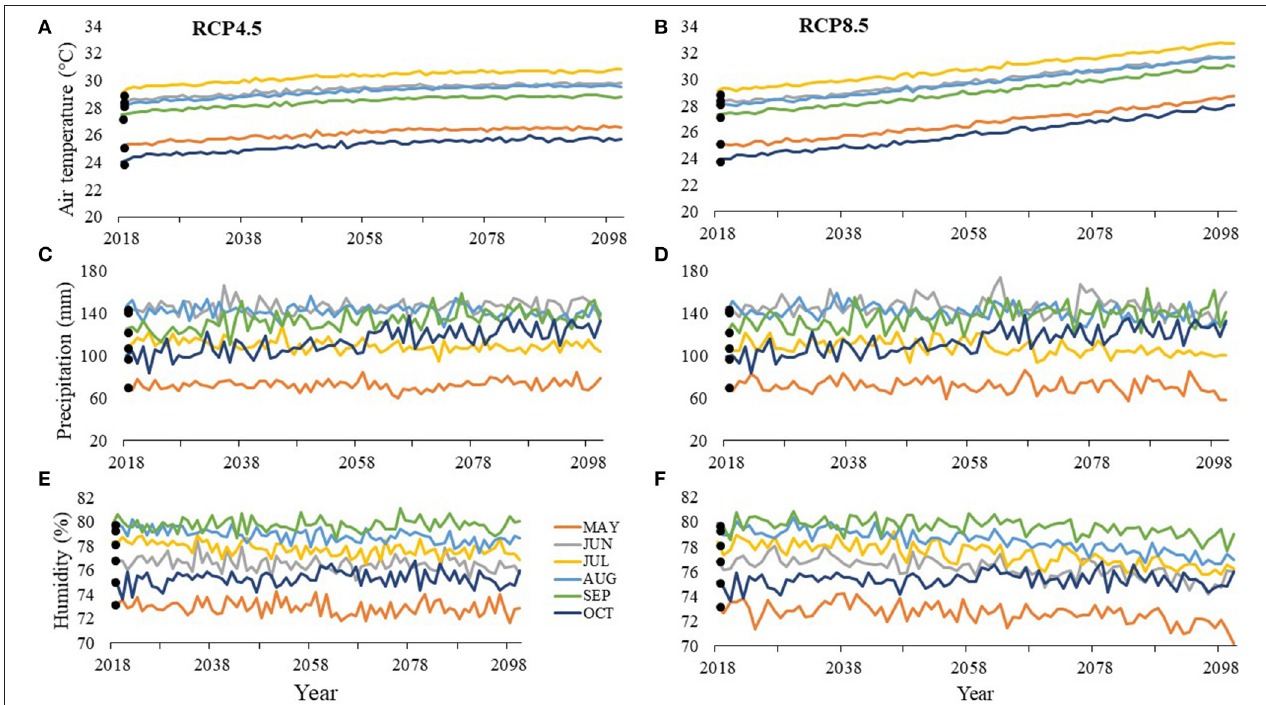
FIGURE 6 | Average values between 2013 and 2016 (solid points) and projected values (lines) for (A, B) air temperature, (C, D) precipitation, and (E, F) humidity at St. George Island (SGI) for months within the nesting and hatching season (May–October). RCP4.5 projections, where greenhouse gas concentrations stabilize, are on the left (A, C, E) , while RCP8.5 projections, where greenhouse gas concentrations continuously increase, are on the right (B, D, F)